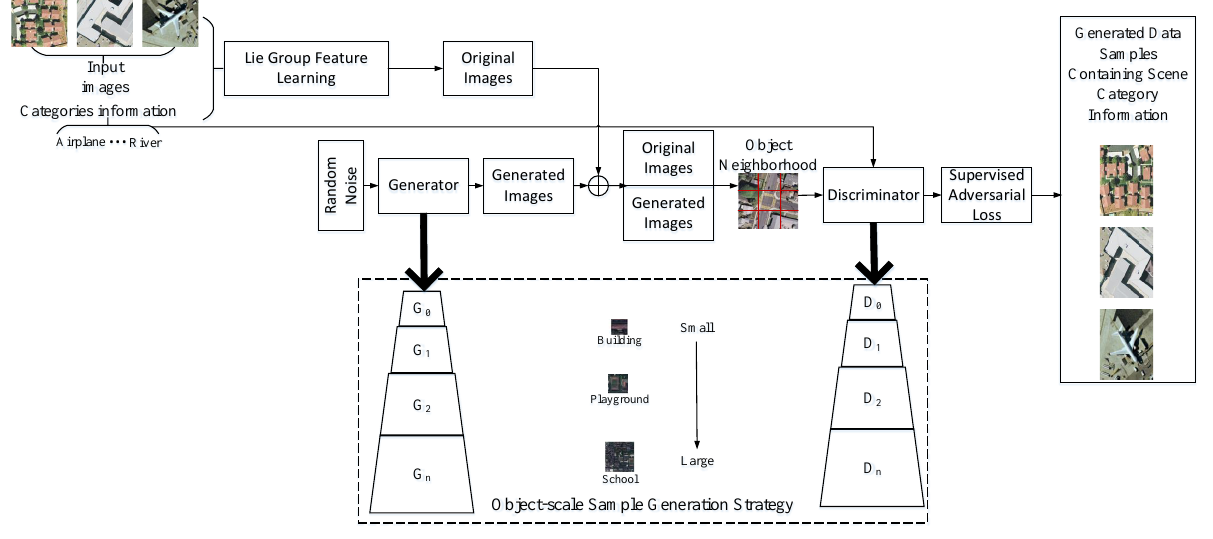
Figure 1. Architecture of our proposed